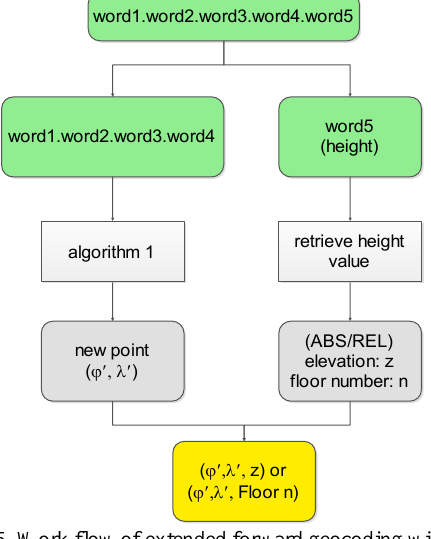
Figure 5. Work flow of extended forward geocoding with five-